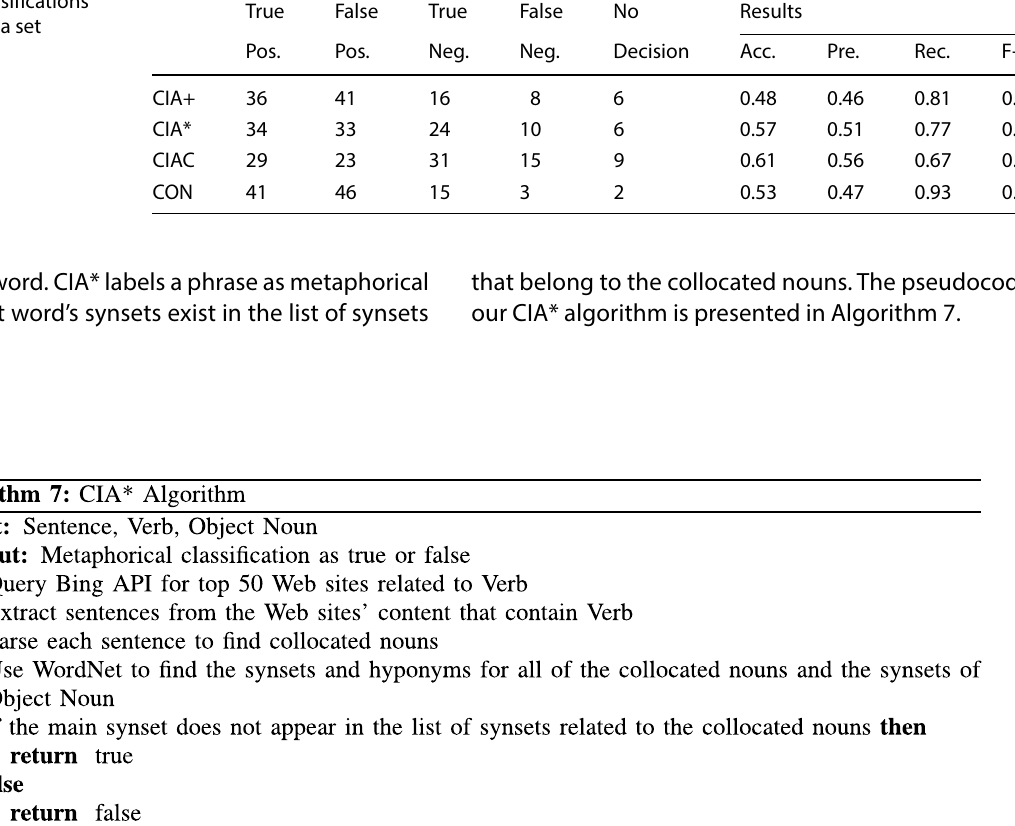
Table 2 Binary classifications and results: full data